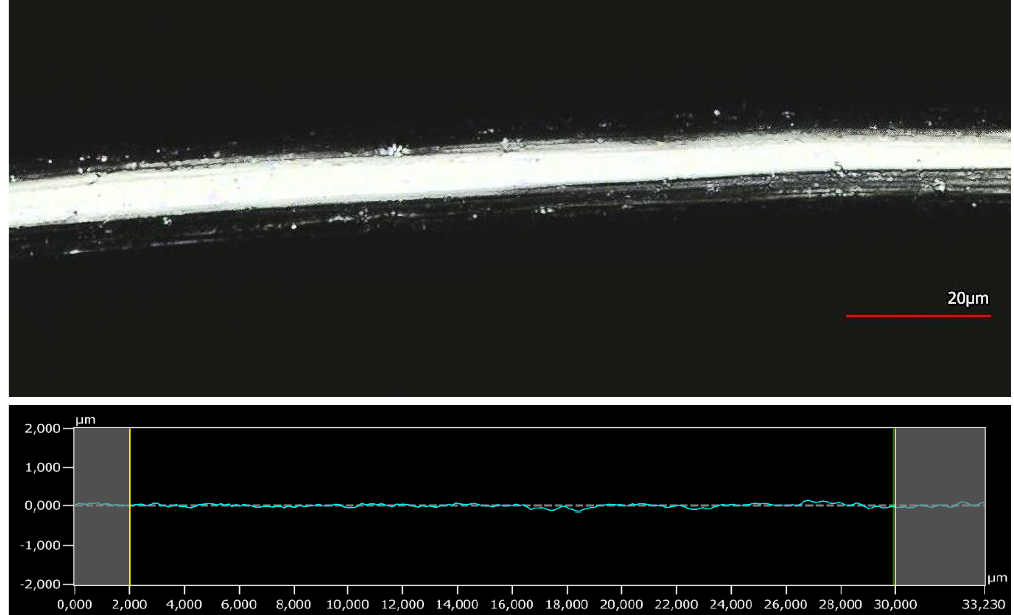
Figure 12. 3D confocal laser-scanning microscope picture of untreated PA 6.6 fibre and roughness profile.